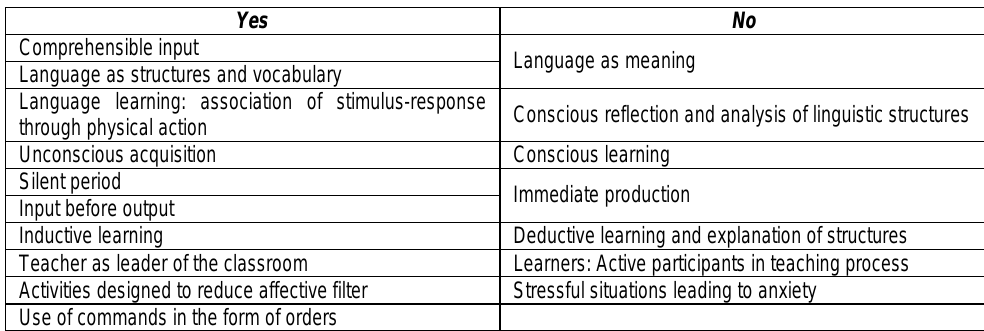
Table 6: Features of Total Physical